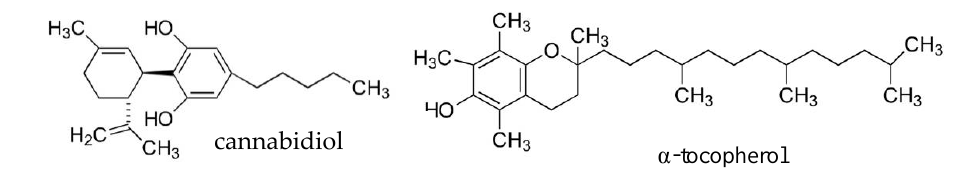
Figure 1. Chemical structures of cannabidiol and α -tocopherol.